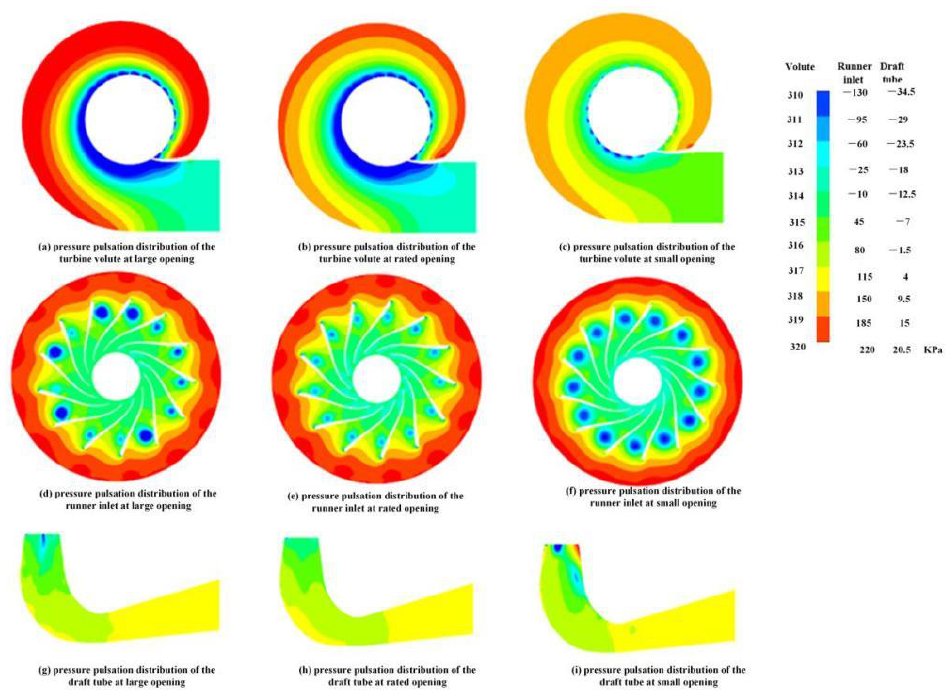
Figure 10. Pressure pulsation distribution in the volute, runner, and draft tube under three